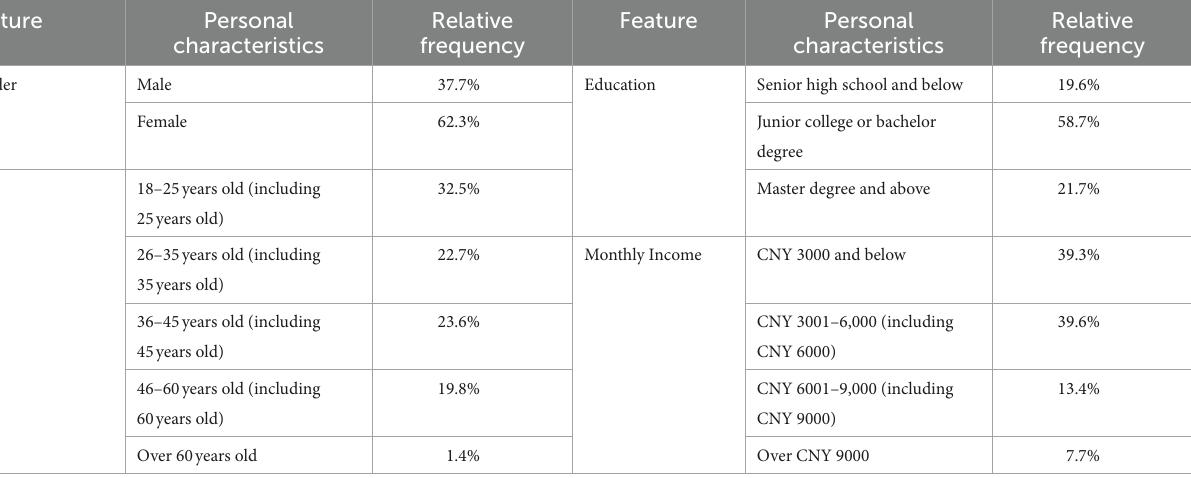
TABLE 2 Demographics of participant ( N = 647).